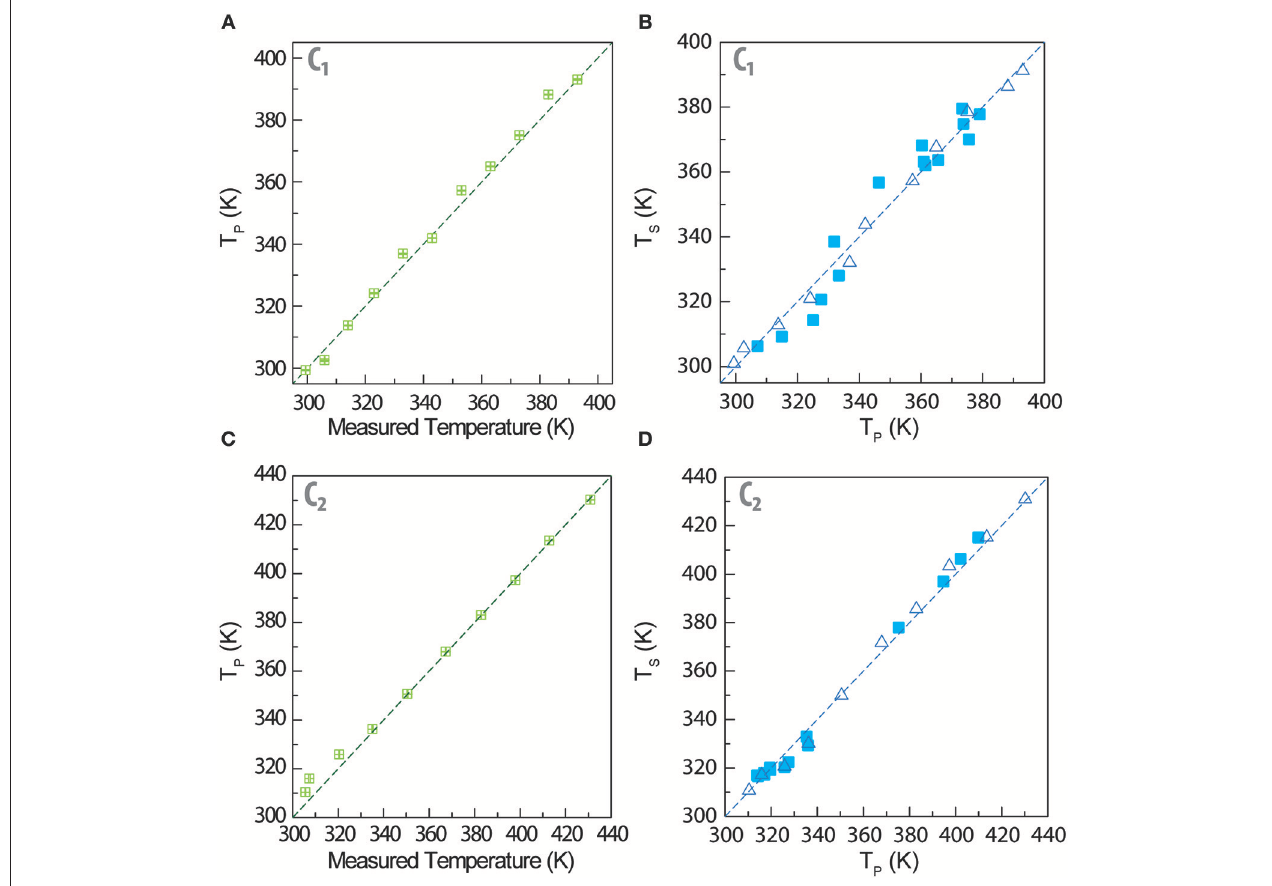
FIGURE 3 | Temperature dependence of the relative thermal sensitivity of primary and secondary thermometers for (A) C 1 and (B) C 2 . (C,D) Temperature dependence of the corresponding temperature uncertainties, respectively.